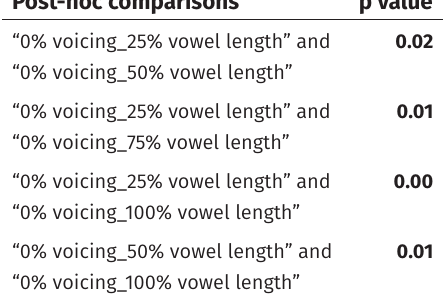
Table 6: Post-hoc Bonferroni test results (significant results only) among the test conditions that presented 0% of